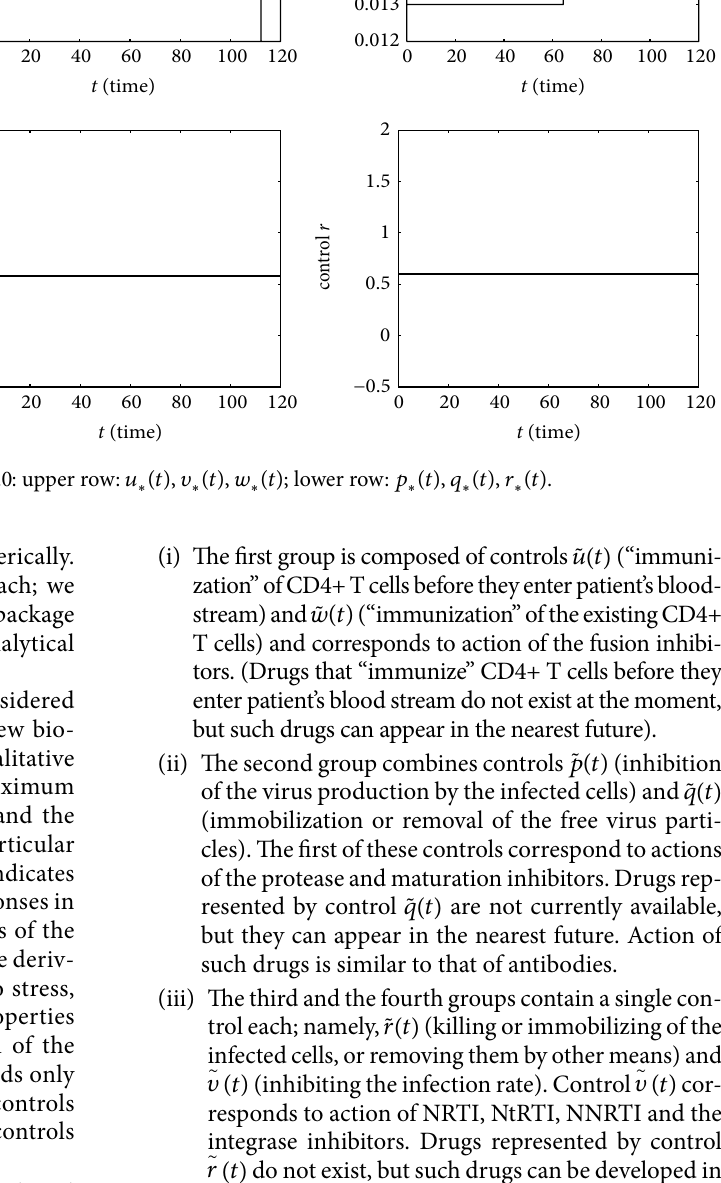
Figure 8: Optimal controls for 푇 = 120.0 : upper row: 푢